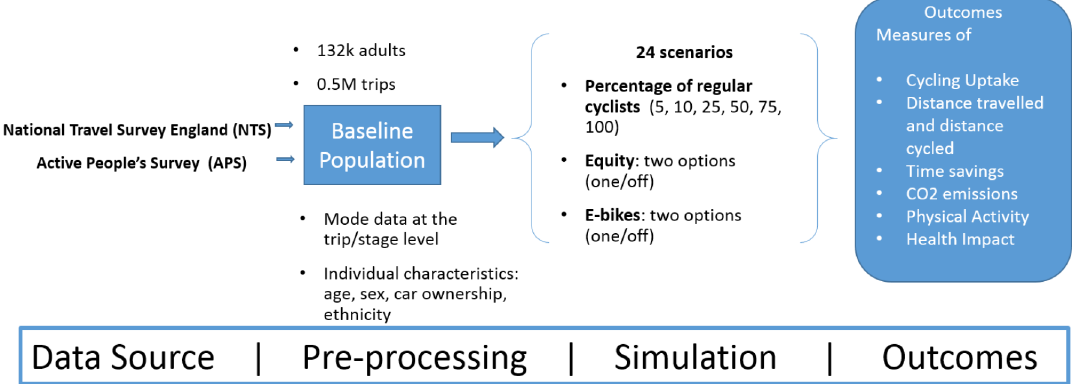
Fig 1. Schematic of main stages in the impacts of cycling